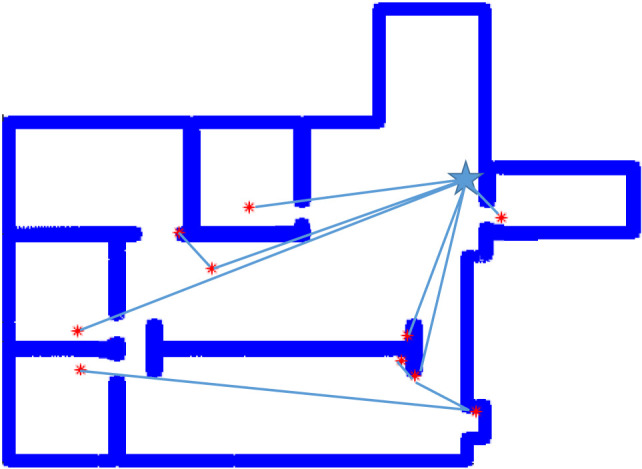
Autolab solution.